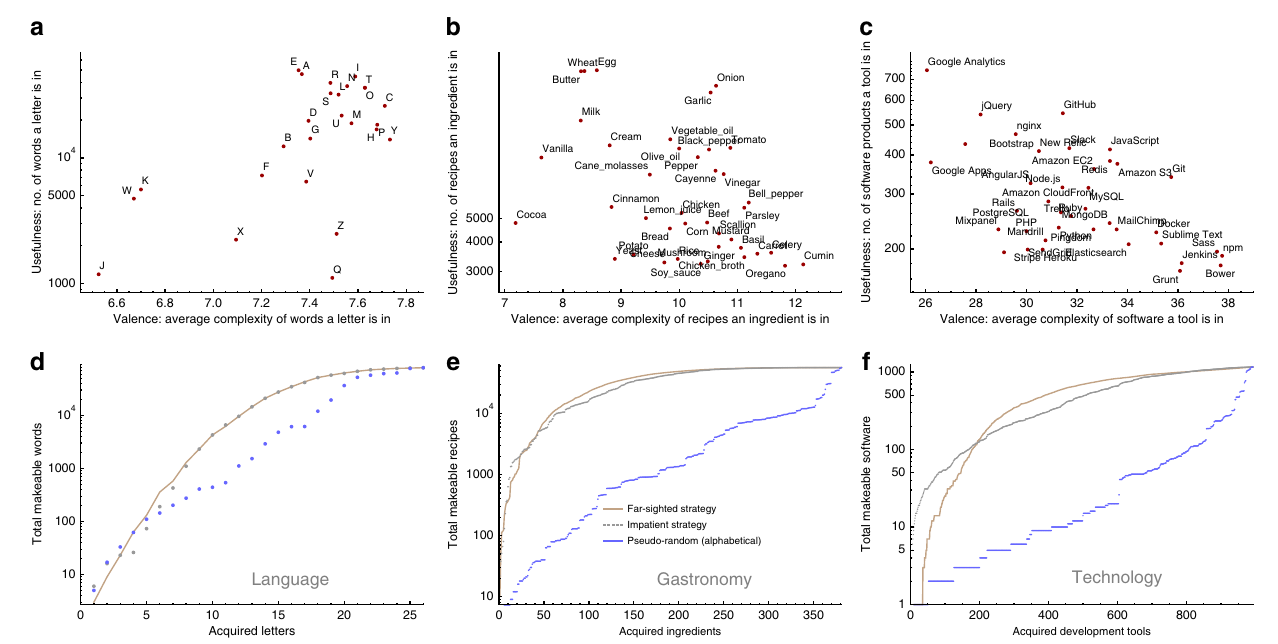
Fig. 5 The success of different innovation strategies depends on the distribution of component properties. a – c Scatter plots of component mean usefulness vs. component valence for our three sectors. For gastronomy and technology, we only show the top 40 components. d – f Both the short-sighted and far- sighted strategies beat a typical random component ordering (here alphabetical), but they diverge from each other only insofar that there are crossings in the bumps